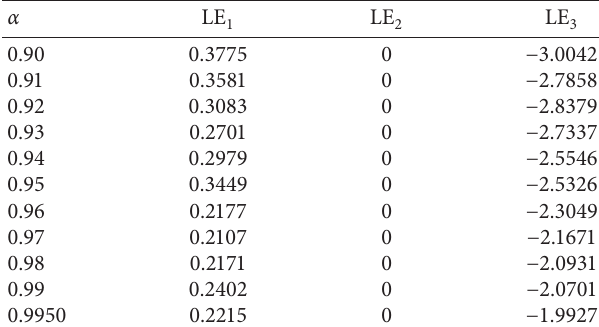
Figure 5: Phase portraits with the order α � 0 . 9 in equations (32)–(34). Table 1: Lyapunov